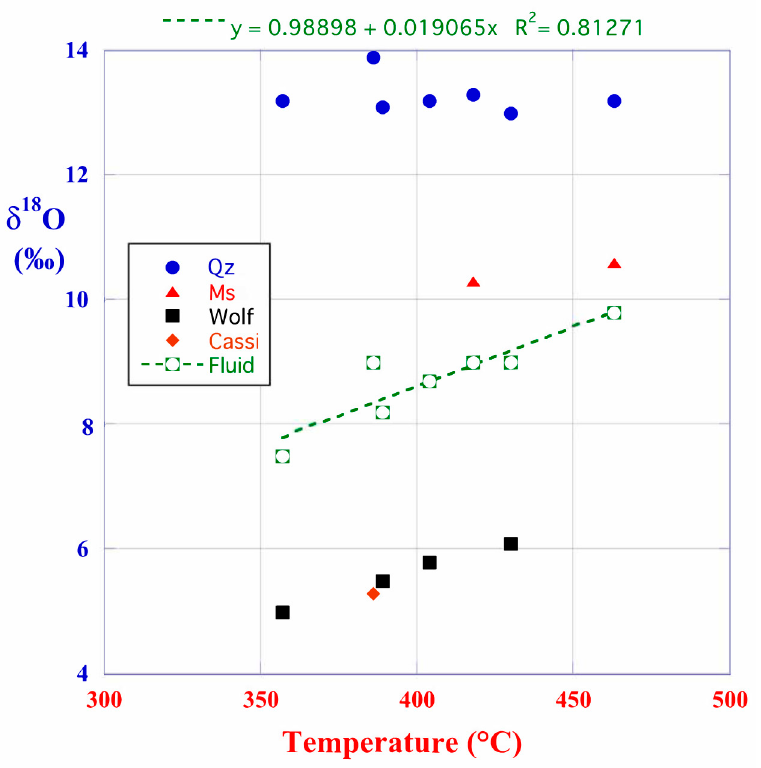
Figure 8. A set of δ 18 O values for mineral pairs is plotted against the calculated oxygen isotopic equilibrium temperatures for the pairs. Oxygen isotope composition of the Takatori hydrothermal fluid that was in equilibrium with the corresponding mineral pair is then calculated using the isotope equilibrium temperature, the δ 18 O value of quartz, and the calibration curve for quartz. The δ 18 O values of the fluid range from +9.8‰ to +7.5‰. The regression line shows a rough positive correlation (R 2 = 0.81) between the δ 18 O value and fluid temperature. Qz: quartz, Ms: muscovite, Wolf: wolframite, Cassi: cassiterite, Fluid: Takatori fluid.